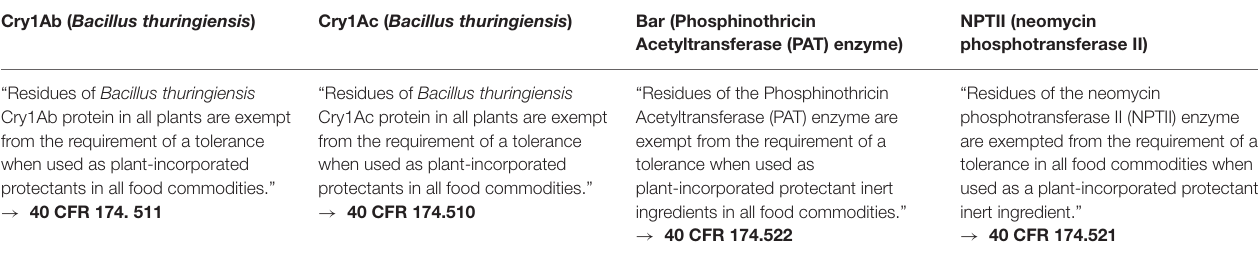
TABLE 3 | Country and product approvals for Cry1Ab, Cry1Ab, NPTII, and bar. Protein Number of Number of countries to events approve